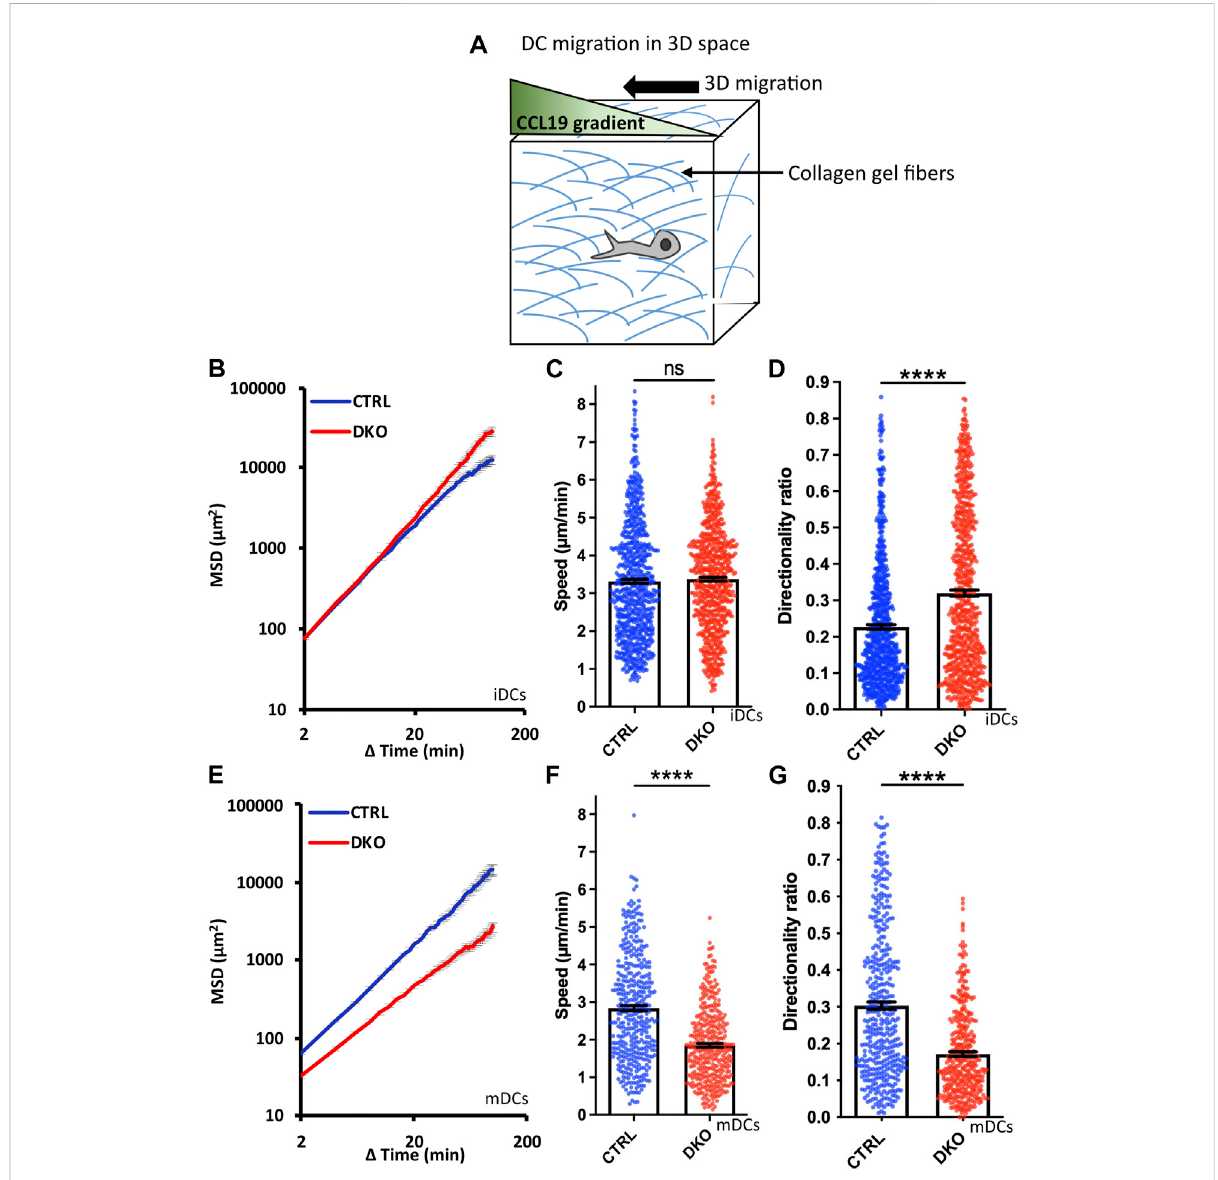
LossofEvlandVASPaltersDCmigrationtowardsCCL19gradientsin3Dcollagengels. (A) Illustrationofexperimentalsetup. Immature (B – D) or mature (E – G) control and DKO DCs were embedded into 1.9 mg/ml collagen gels. The upper gel surface was covered with medium containing 650 ng/ml CCL19. DC migration was monitored by bright- fi eld real-time microscopy for 6 h. Images were obtained at 2 min intervals and analyzed in automated manner. (B,E) Quanti fi cation of Mean Squared Displacement (MSD). Speed (C,F) and directionality (D,G) are depicted as mean